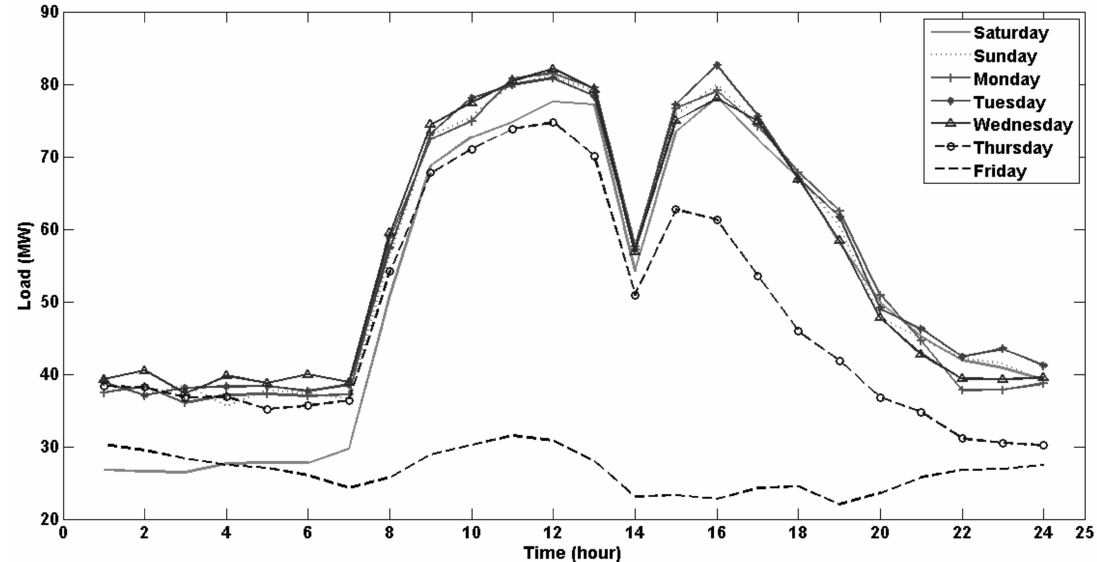
Figure 3. Hourly load curve of Shams Abad industrial zone in spring over a